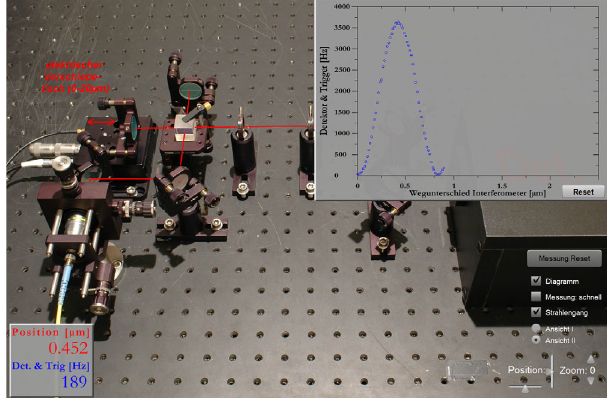
FIG. 5. Interactive screen experiment on single-photon inter- ference [51].